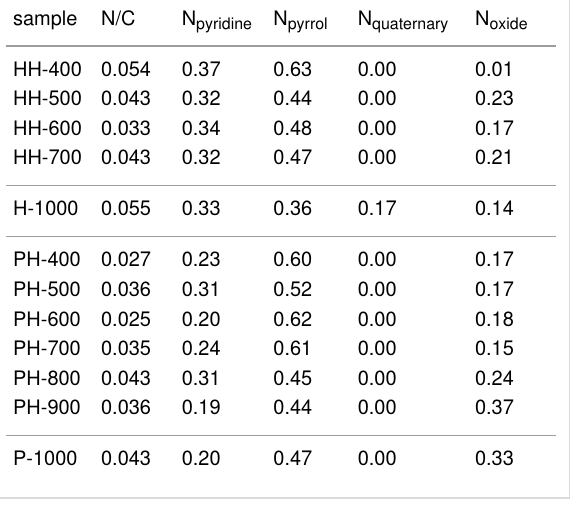
Table 4: Distribution of N-species in HH- and PH-series carbon materi-